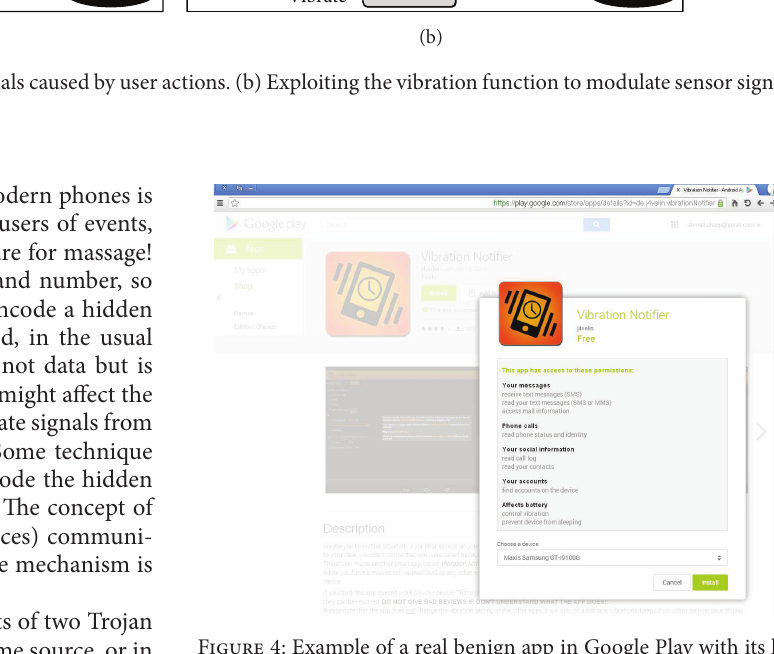
Figure 4: Example of a real benign app in Google Play with its list of requested permissions, which is a superset of the permissions required for our source